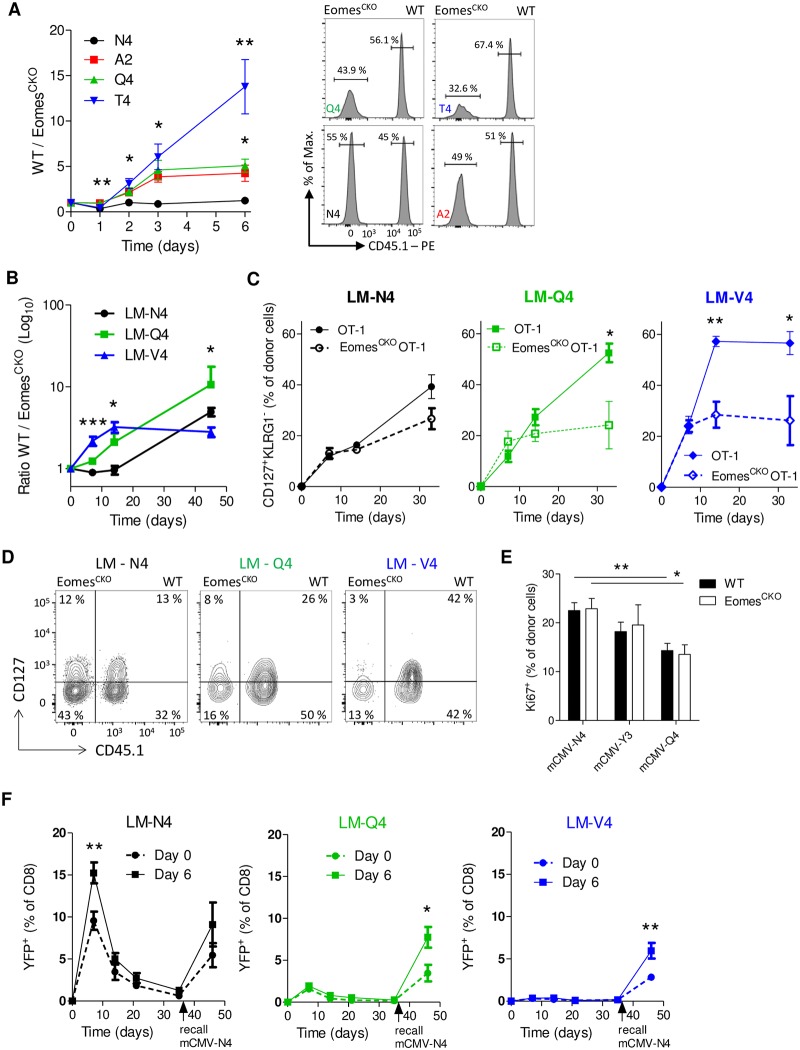
Eomes promotes memory precursor formation early after activation.(A) WT (CD45.1+) and EomesCKO (CD45.2+) OT-1 cells were mixed in a 1:1 ratio and stimulated with the indicated peptides. The ratio between cell populations was followed over time by flow cytometry. (B-D) OT-1 (CD45.1/2+) and EomesCKO OT-1 cells (CD45.2+) were mixed in a 1:1 ratio, and 104 cells were injected into WT recipients (CD45.1+). Two days later, recipients were infected with LM-N4, LM-Q4, or LM-V4. (B) Ratio between WT and EomesCKO cells in blood over time. (C) Fraction of CD127+KLRG1- cells among donor cells. (D) Representative FACS plots for day 14 were gated for CD8+CD45.2+ cells. (E) OT-1 (CD45.1/2+) and EomesCKO OT-1 cells (CD45.2+) were mixed in a 1:1 ratio, and 104 cells were injected into WT recipients (CD45.1+). One day later, recipients were infected with mCMV-N4, mCMV-Y3, or mCMV-Q4. Seven days after infection, Ki67 expression was determined in splenic donor cells by flow cytometry. (F) EomesiCKO cells were transferred in WT recipients. Mice were infected with LM-N4, LM-Q4, or LM-V4 and injected with Poly(I:C) 0 or 6 days after infection. After 4 weeks, mice were reinfected with mCMV-N4. The fraction of eYFP+ donor cells was followed in the blood. Experiments show representative data from at least two (B-F) or four (A) independent experiments using 3–5 mice per group. In (A,B,E), ANOVA followed by Bonferroni posttesting was used; in (C,F), Student t test was used to analyze difference between groups. Shown are means ± s.e.m. *P < 0.05, **P < 0.01, ***P < 0.001. Values for each data point can be found in S1 Data. A2, SAINFEKL; EomesCKO, Eomesflox/floxCD4Cre; EomesiCKO, EomesFL/FLOT-1+/-RosaStop-EYFPMx1Cre/+; eYFP, enhanced yellow fluorescent protein; FACS, fluorescence-activated cell sorting; LM, L. monocytogenes; mCMV, murine cytomegalovirus; N4, SIINFEKL; Poly(I:C), polyinosine-polycytidylic acid; Q4, SIIQFEKL; T4, SIITFEKL; V4, SIIVFEKL; WT, wild-type; Y3, SIYNFEKL.